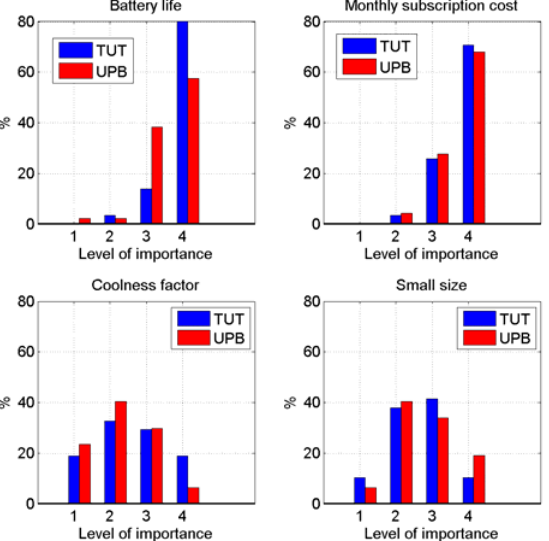
Figure 7. Histograms of preferences regarding the top and bottom two mobile device features in the context of mobile